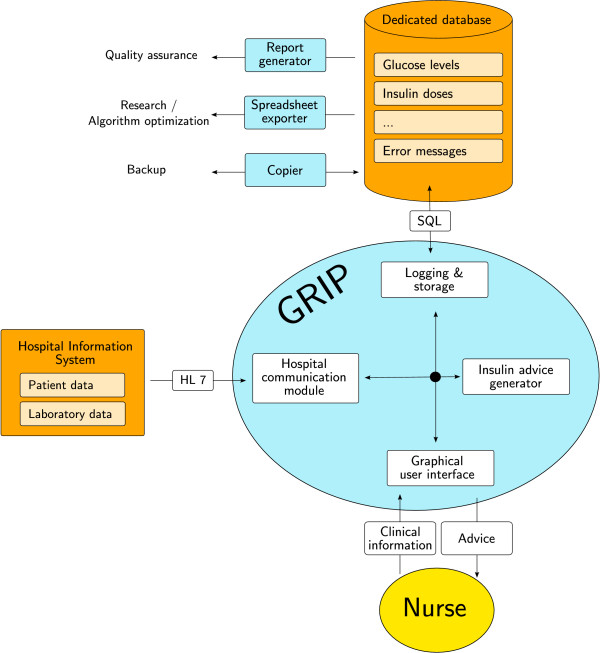
High-level overview of GRIP. Grip contains four major components: a component to interface with the hospital information system, a component to interface with the nurse, a component that calculates the advice that GRIP gives, and a component that logs errors and stores all data GRIP generates. HL7 : Health Level 7. SQL : Standard Query Language.